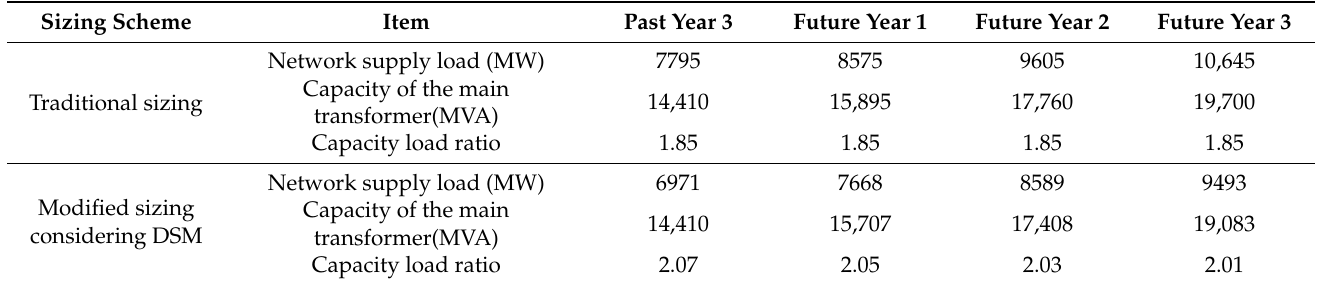
Table 8. Load balance